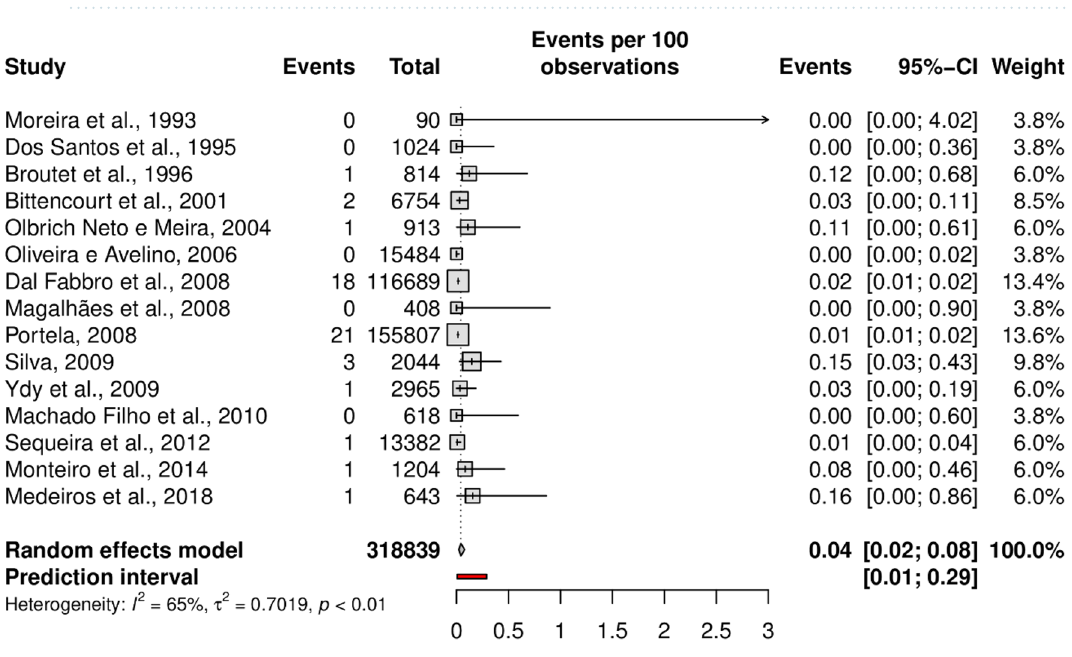
Figure 3. Forest plot of the prevalence of HTLV-2 infection, as detected by confirmatory tests, in pregnant